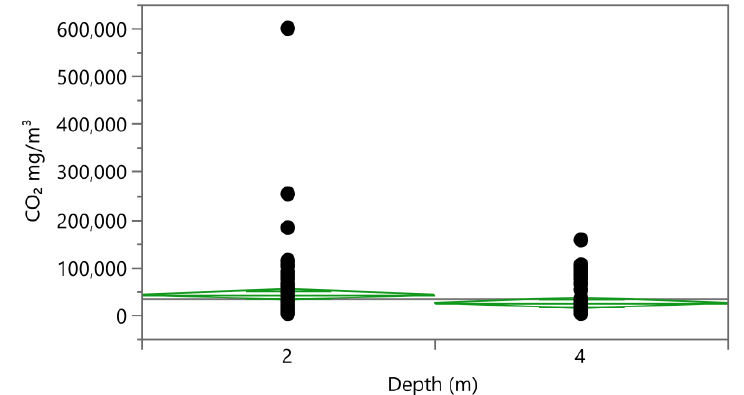
Figure 4. Analysis of CO 2 variability with the influence of the date.